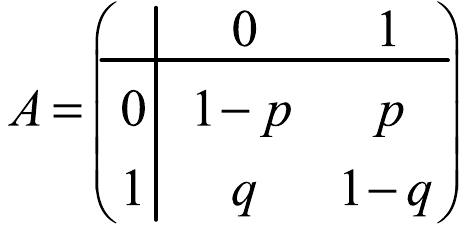
Figure 1. Transition